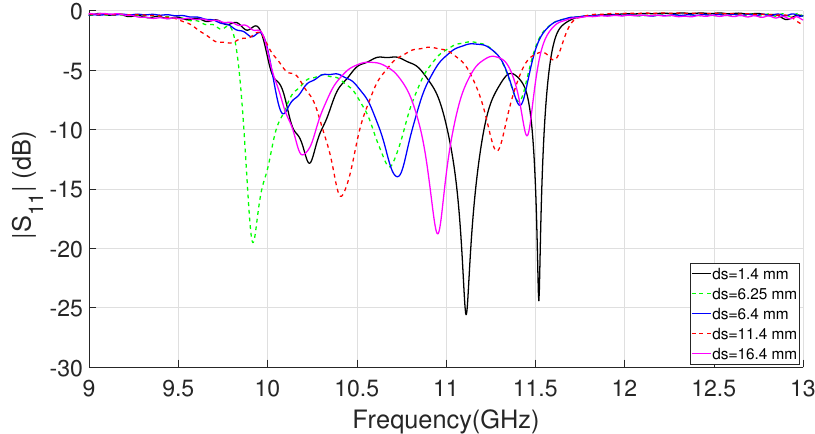
Figure 9. Simulated | S 11 | of analyzed filtering antenna for different lengths, (ds) in Figure 4c, between filter 1 and the radiant element (df = 7 mm).